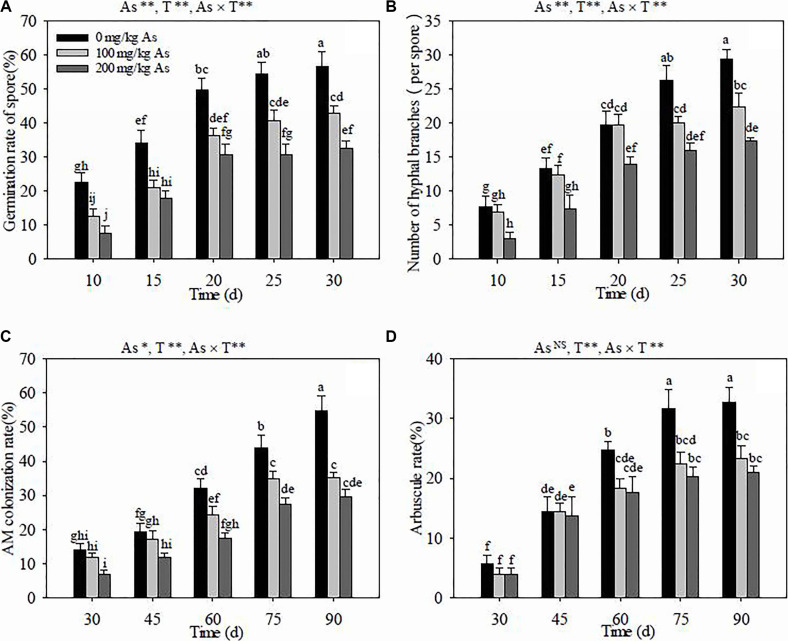
Effects of arsenic stress and culture (or colonization) time on the spore germination rate (A), hyphal branch number (B), arbuscular mycorrhiza (AM) colonization rate (C), and arbuscule rate (D) of Rhizoglomus intraradices. Different letters indicate significant differences (P < 0.05) using Tukey’s test. Data are presented as the mean ± SD (n = 3). NS, not significant; As, arsenic addition levels; As×AMF, significant interactive effects of As level×R. intraradices; T, culture or colonization time. *P < 0.05; **P < 0.01.